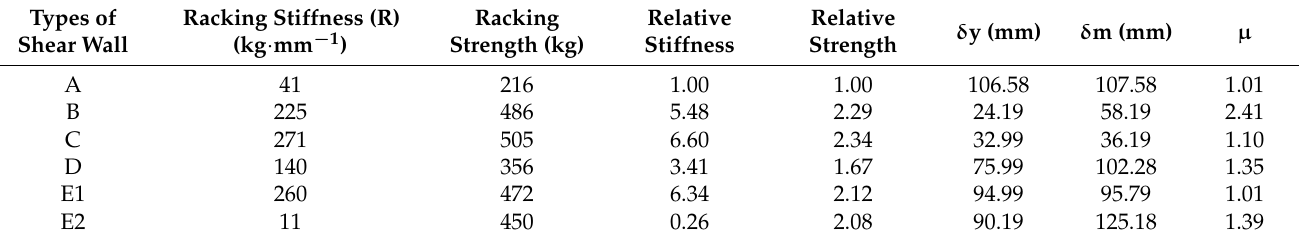
Table 1. The stiffness and strength of various shear wall panel component